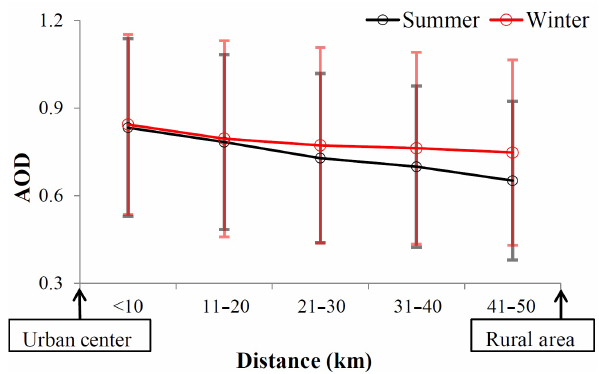
Figure 7. Mean AOD as a function of distance from the urban ge- ometrical center of all cities in winter (red curve with open circles) and summer (black curve with open circles). The distance ranges are < 10, 11–20, 21–31, 31–40, and 41–50km from the urban geo- metrical center. Error bars are shown.